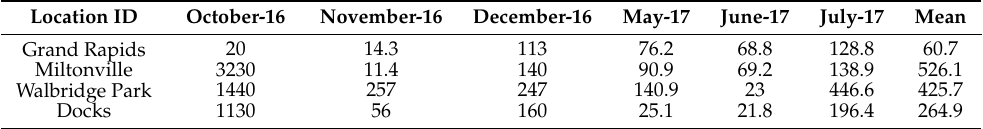
Figure 2. Box plot displaying E. coli cfu 100 mL − 1 of water sample within the four sites across all sampling events. The line within each box indicates the median value. The whiskers above and below the box indicate the maximum and minimum values of E. coli load within the four sites. Table 1. E. coli counts per sampling month in four sites (cfu 100 mL − 1 water) .